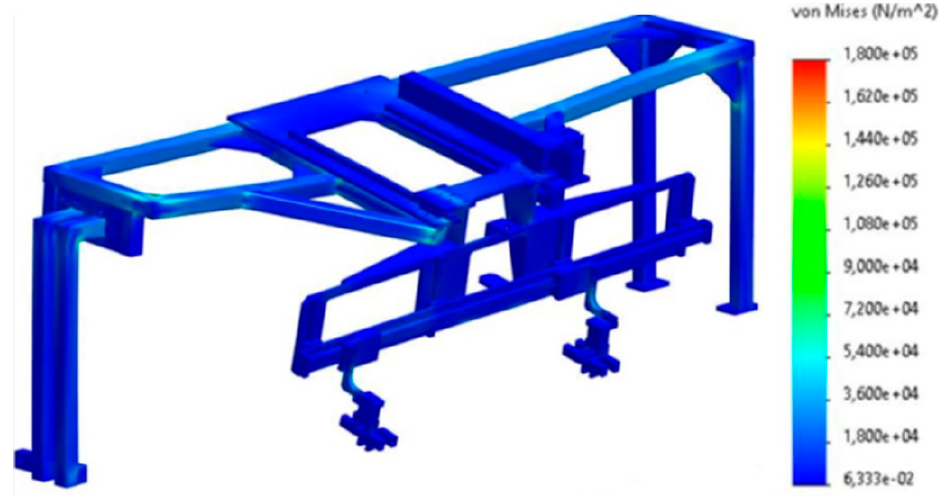
Figure 15. Effective stresses in the robotic manipulator’s structure under working loads.